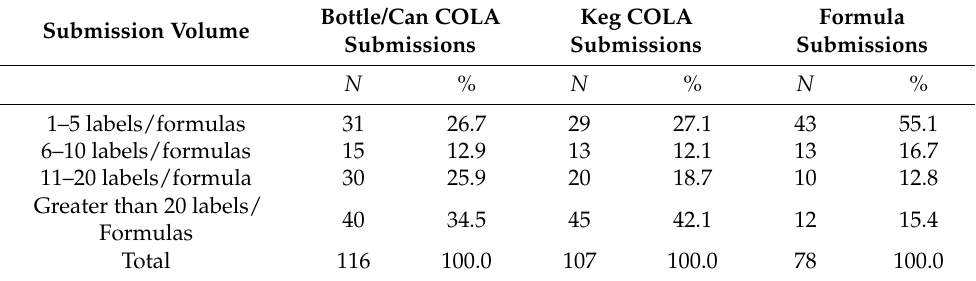
Table 4. Brewery Sample Characteristics: Frequency Data for Submission Volume of COLAs and